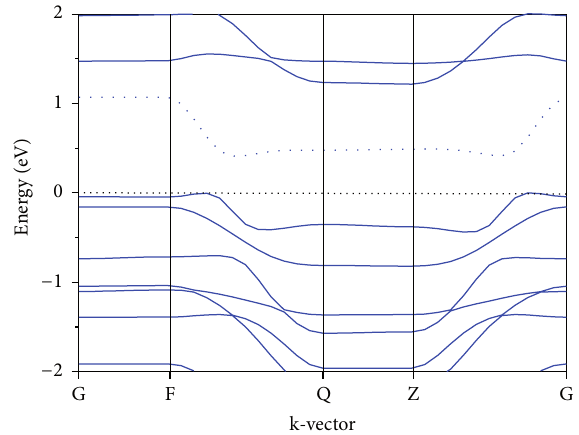
Figure 9: The electronic band structure of N2-doped single walled zigzag (5,0) BNT. The Fermi level is set corresponding to zero energy and represented by dotted line.